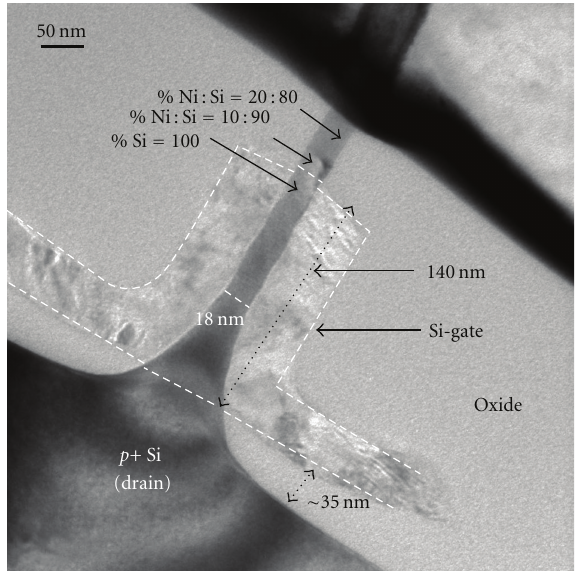
Figure 8: Cross-sectional TEM of pTFET showing a very narrow uniform wire surrounded with gate and silicide at